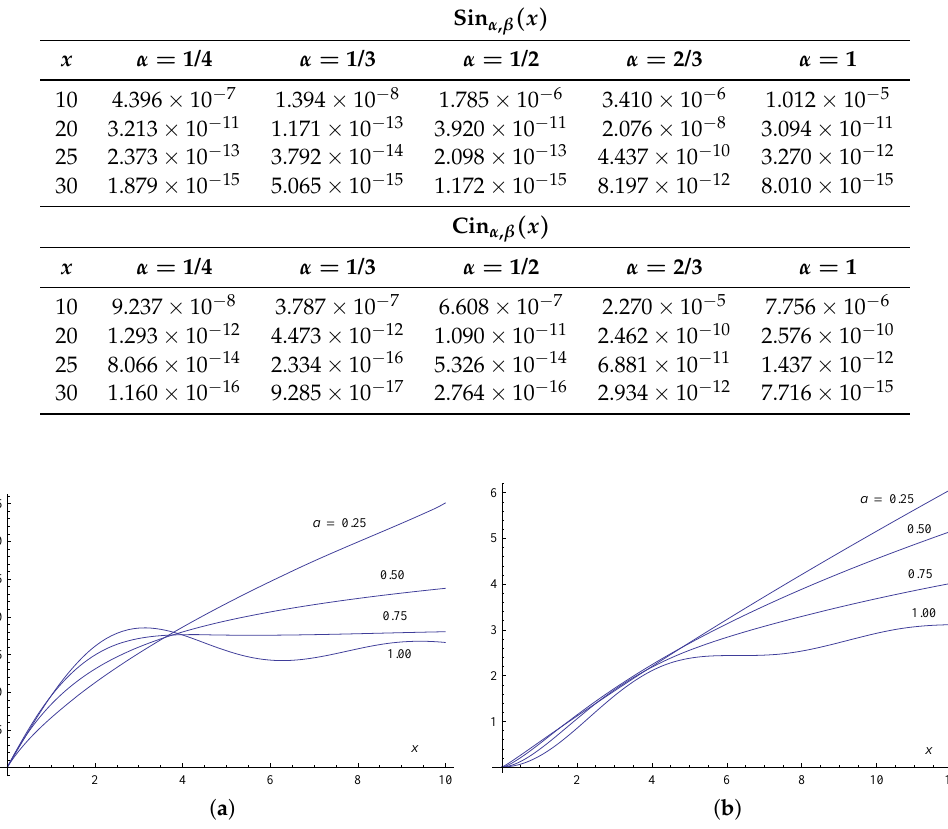
Table 3. The absolute relative error in the computation of Sin α , β ( x ) and Cin α , β ( x ) from Theorems 3–5 for different α and x when β = 4/3.